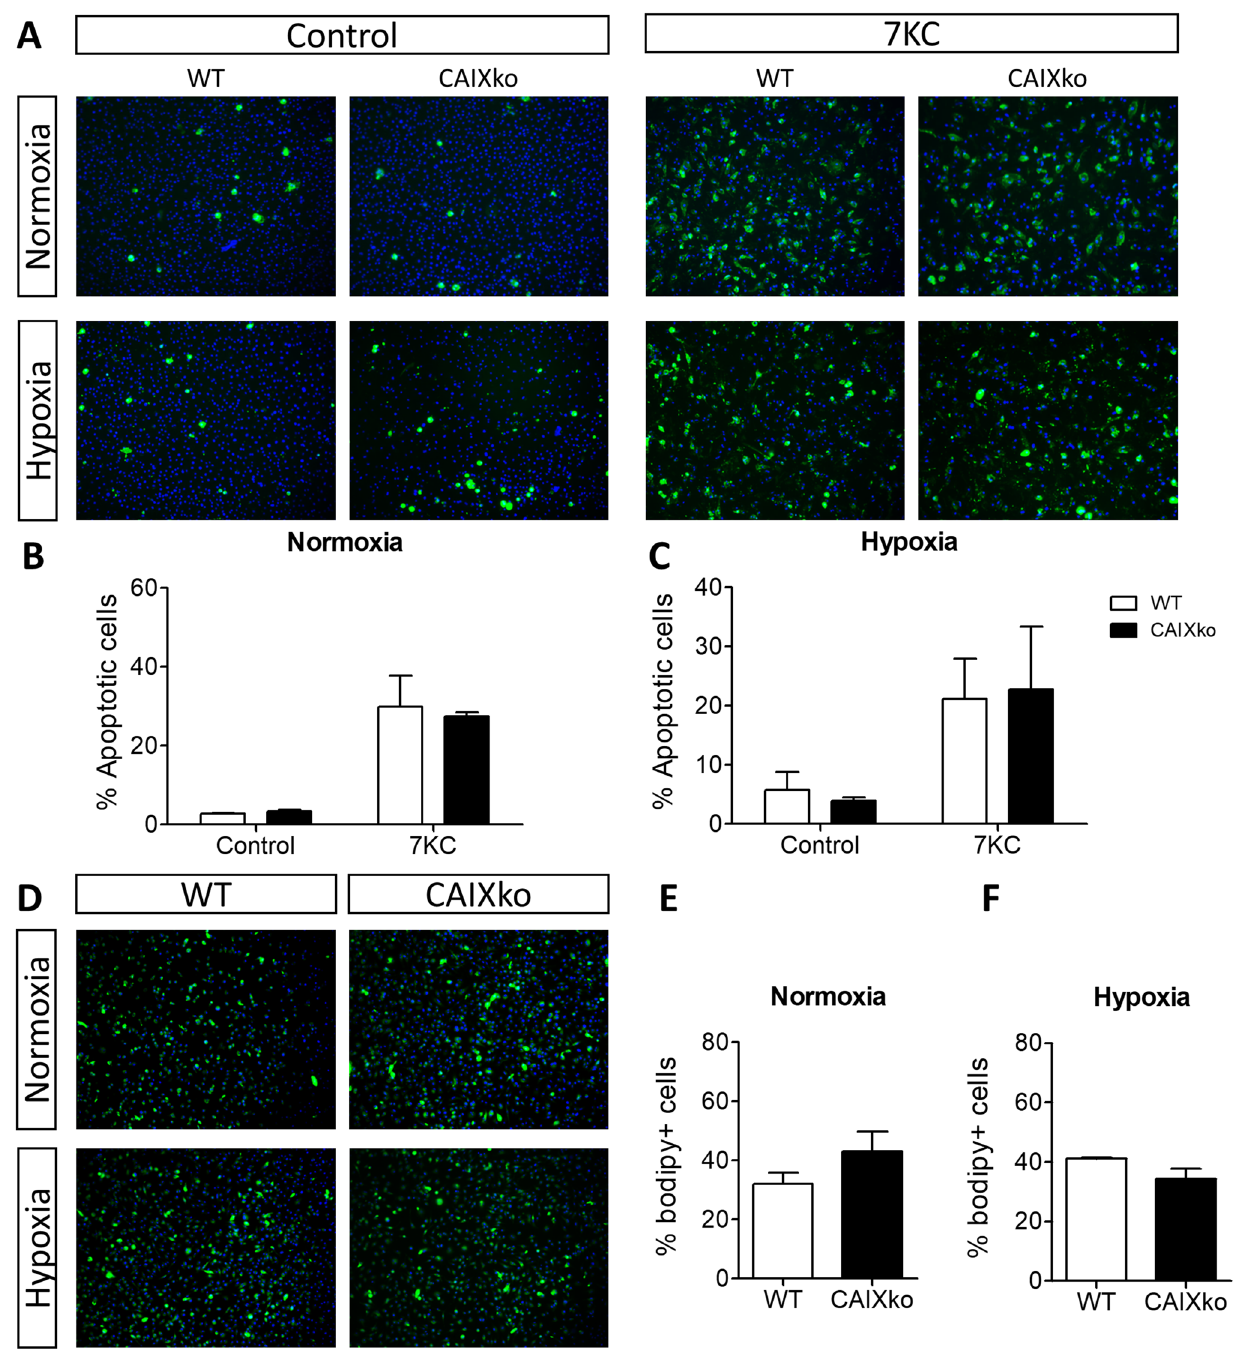
Figure 3. CAIXko did not alter BMDM apoptosis or lipid uptake. Apoptosis was induced by incubating cells with 50 µM 7-ketocholesterol for 24 h in all experiments. ( A ) Representative photographs of apoptotic cells (annexin positive) in WT and CAIXko BMDMs in normoxia and hypoxia (1% O 2 ). ( B ) BMDM (n = 3) apoptosis in normoxia or ( C ) hypoxia (1% O 2 , 24 h). ( D ) Representative photographs of BMDMs after lipid uptake (Topfluor positive) in WT and CAIXko BMDMs in normoxia and hypoxia (1% O 2 ). ( E ) BMDM lipid uptake in normoxia (n = 3) or ( F ) hypoxia. All results show mean ±